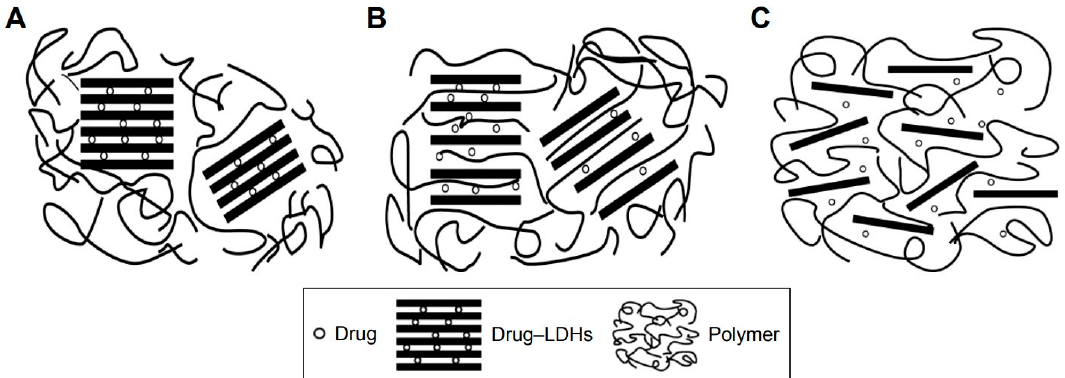
Figure 3. Schematic diagrams of ( A ) organic-coated inorganic hybrid layered double hydroxide (LDH) nanoparticles; ( B ) organic-intercalated inorganic hybrid LDH nanoparticles; and ( C ) organic–inorganic hybrid LDH nanosheets [50]. Reproduced from [50] with permission from Dove Medical Press, 2018.